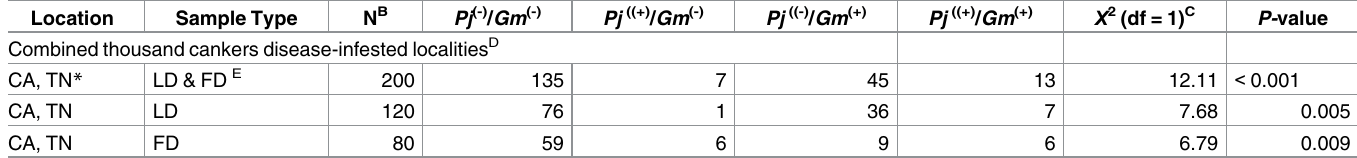
Table 2. Comparisons of molecular detection of Geosmithia morbida ( Gm ) and Pityophthorus juglandis ( Pj ) in any of the drilled samples (per tree) confirmed that a sample (tree) is positive for either organism A .